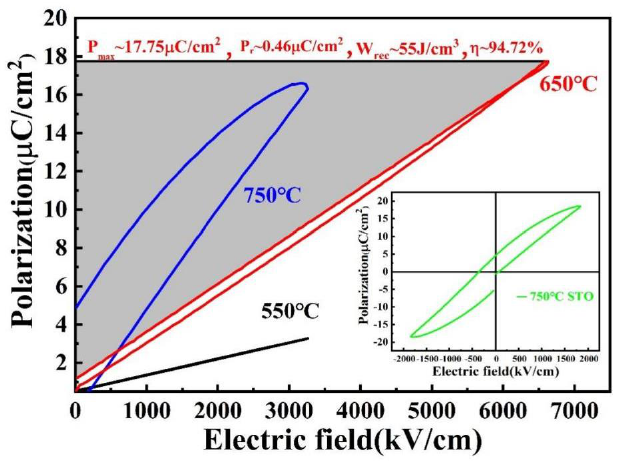
Figure 6. Unipolar P - E loops of STO films annealed at different temperatures. The inset shows bipolar P - E loop of the STO film annealed at 750 °C.